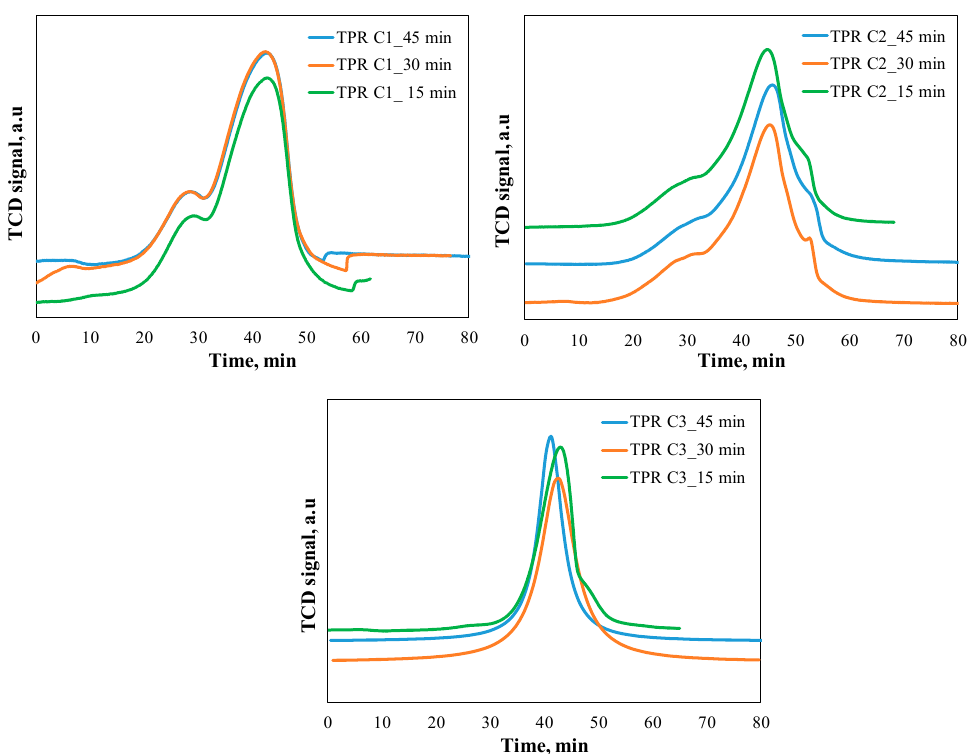
Figure 3. TPR profiles for C1, C2 and C3 at di ff erent reduction times on stream.